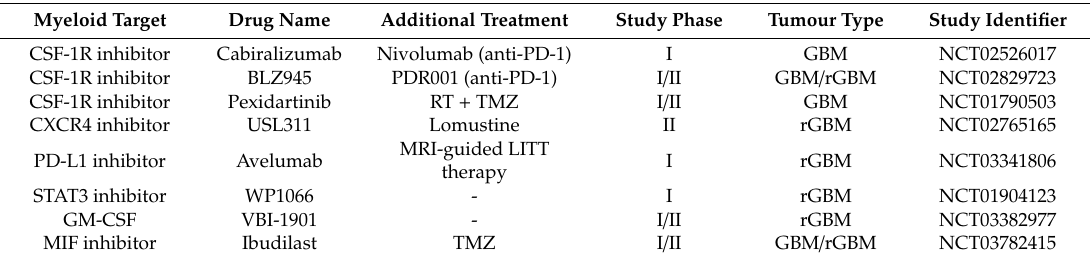
Table 1. Examples of current clinical trials targeting TAMs in GBM. RT: radiotherapy; TMZ: temozolomide; MRI: magnetic resonance imaging; LITT: laser interstitial thermal therapy; rGBM: relapsed / recurrent